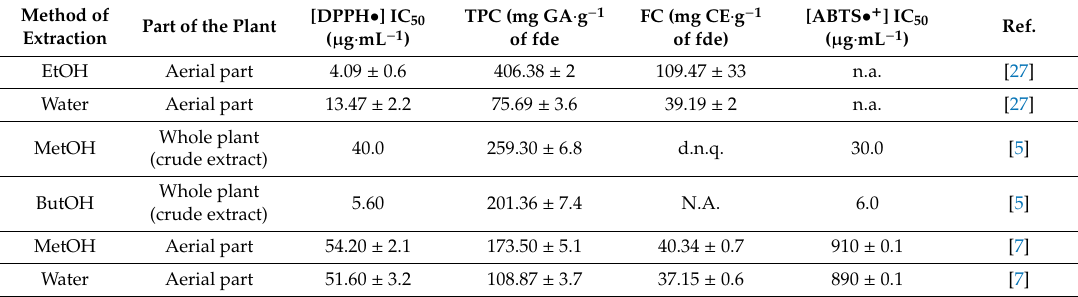
Table 3. Main antioxidant parameters reported for C. coccineum